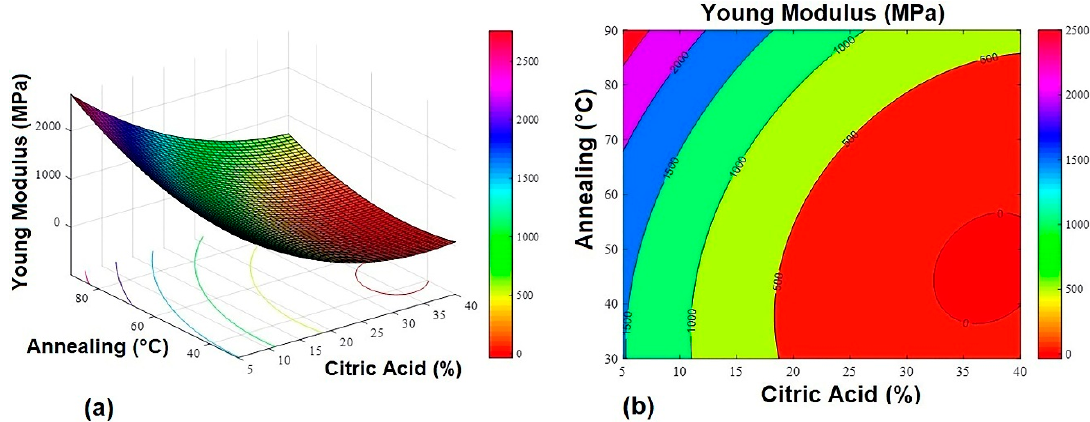
Figure 2. Young’s modulus response surface graphs. ( a ) 3D response surface graph and ( b ) contour plot.